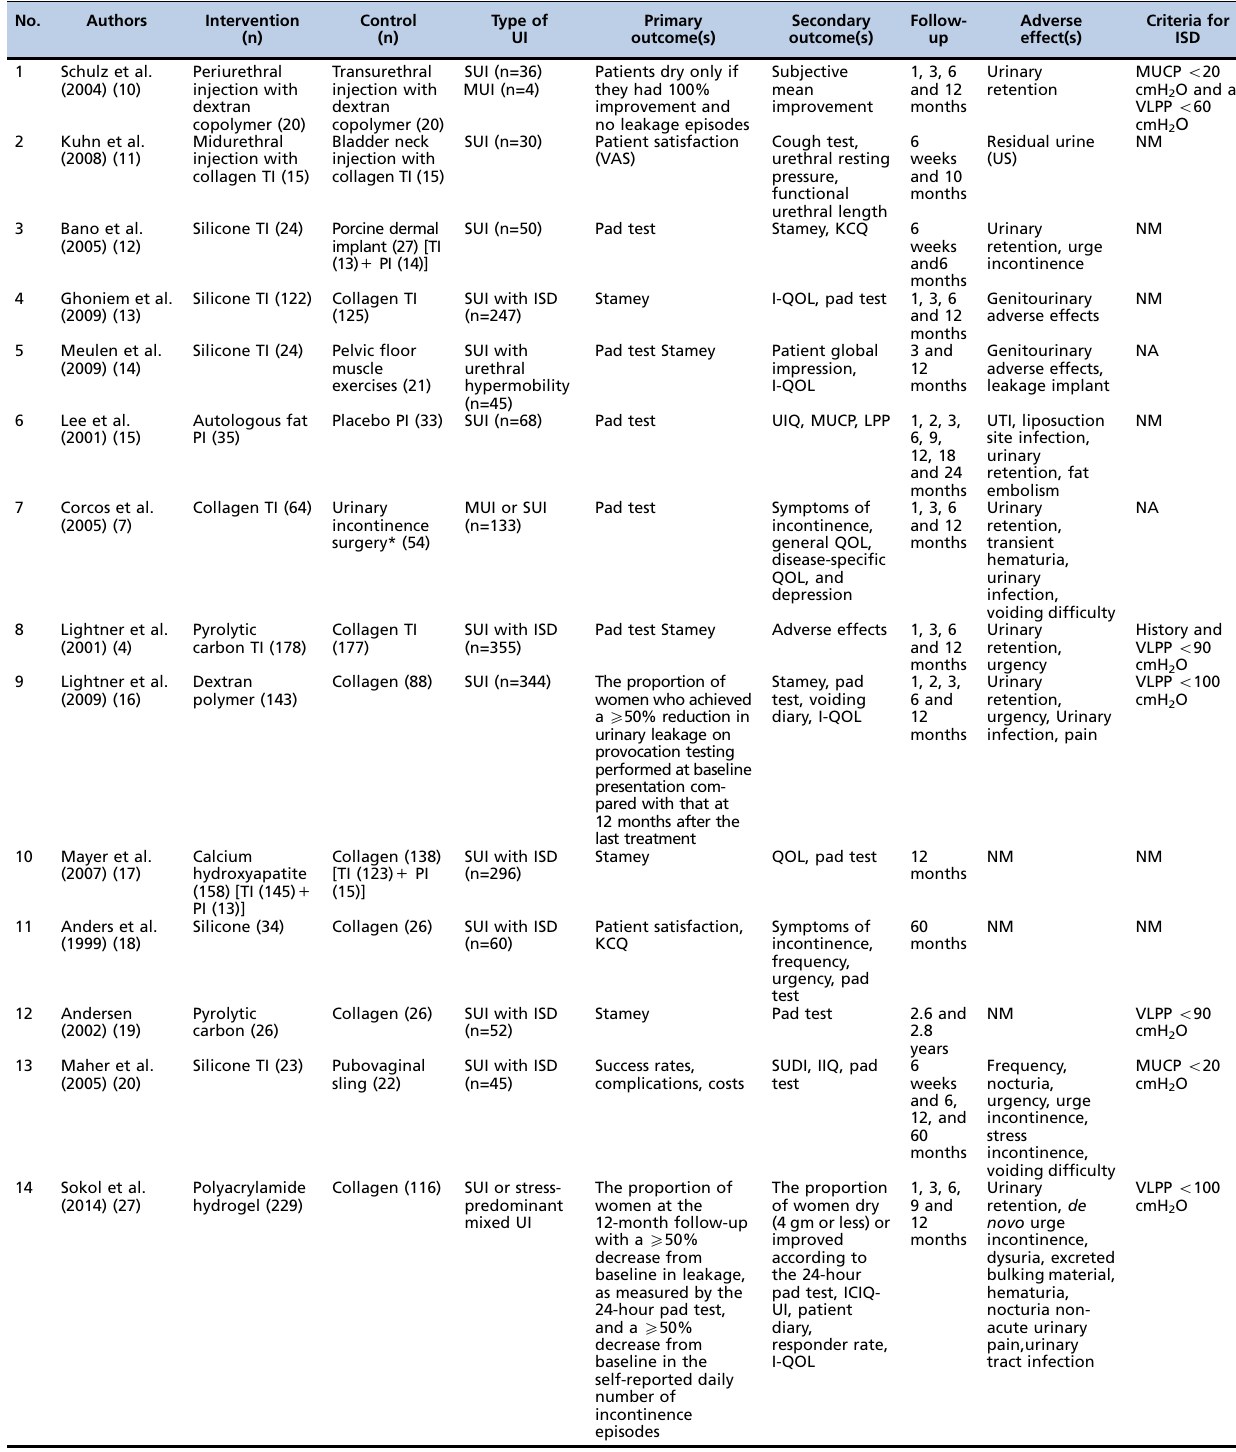
Table 1 - Summary of the selected studies and their methodological quality.